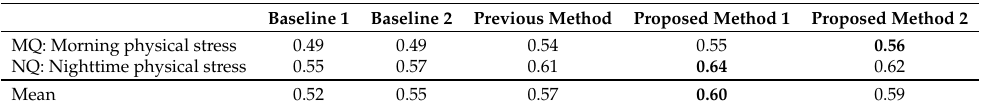
Table 7. Estimation accuracy of five evaluation methods. Estimation values are averaged over MQ and NQ.